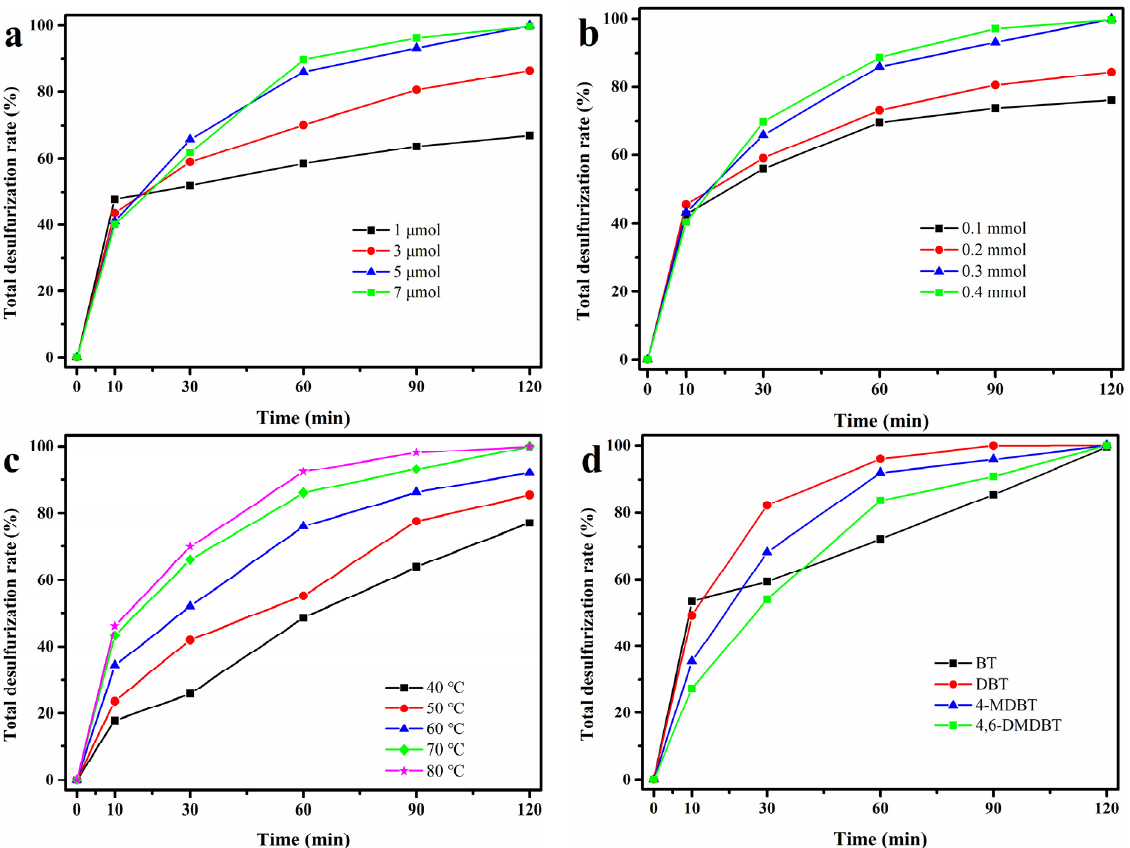
Figure 7. Desulfurization pro fi le of a multicomponent model fuel catalyzed by PW 2 Mo 2 @HPMOS containing di ff erent amounts of PW 2 Mo 2 using 0.3 mmol H 2 O 2 at 70 °C ( a ); the e ff ect of H 2 O 2 amount on EODS catalyzed by PW 2 Mo 2 @HPMOS containing 5 µmol of PW 2 Mo 2 at 70 °C ( b ); the e ff ect of temperature on EODS catalyzed by PW 2 Mo 2 @HPMOS containing 5 µmol of PW 2 Mo 2 using 0.3 mmol H 2 O 2 at 70 °C ( c ); desulfurization pro fi le of four sul fi des catalyzed by PW 2 Mo 2 @HPMOS containing 5 µmol of PW 2 Mo 2 using 0.3 mmol H 2 O 2 at 70 °C ( d ).